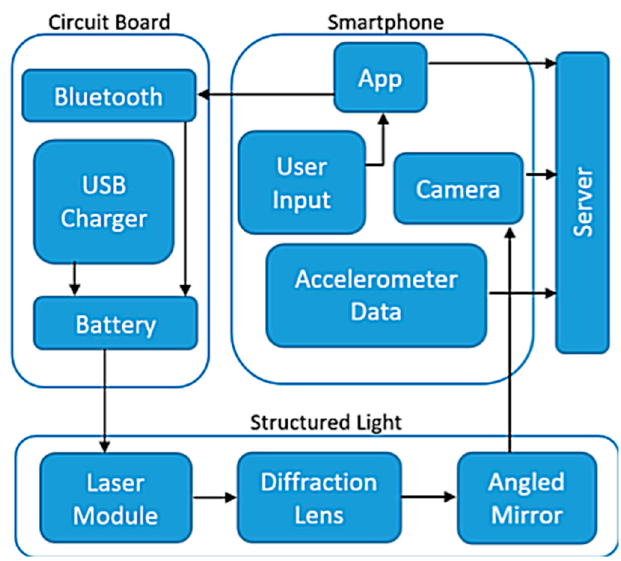
Figure 1. The structured light system designed for the DDRS device as a hardware add-on for the smartphone.